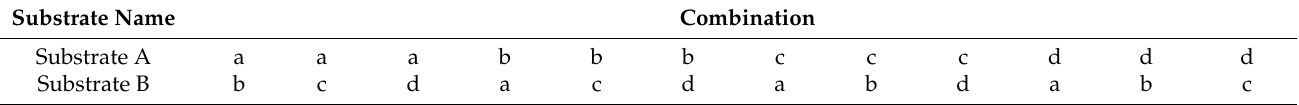
Figure 4. The device diagram of the experiment IV. Table 2. The twelve combinations for the substrates.